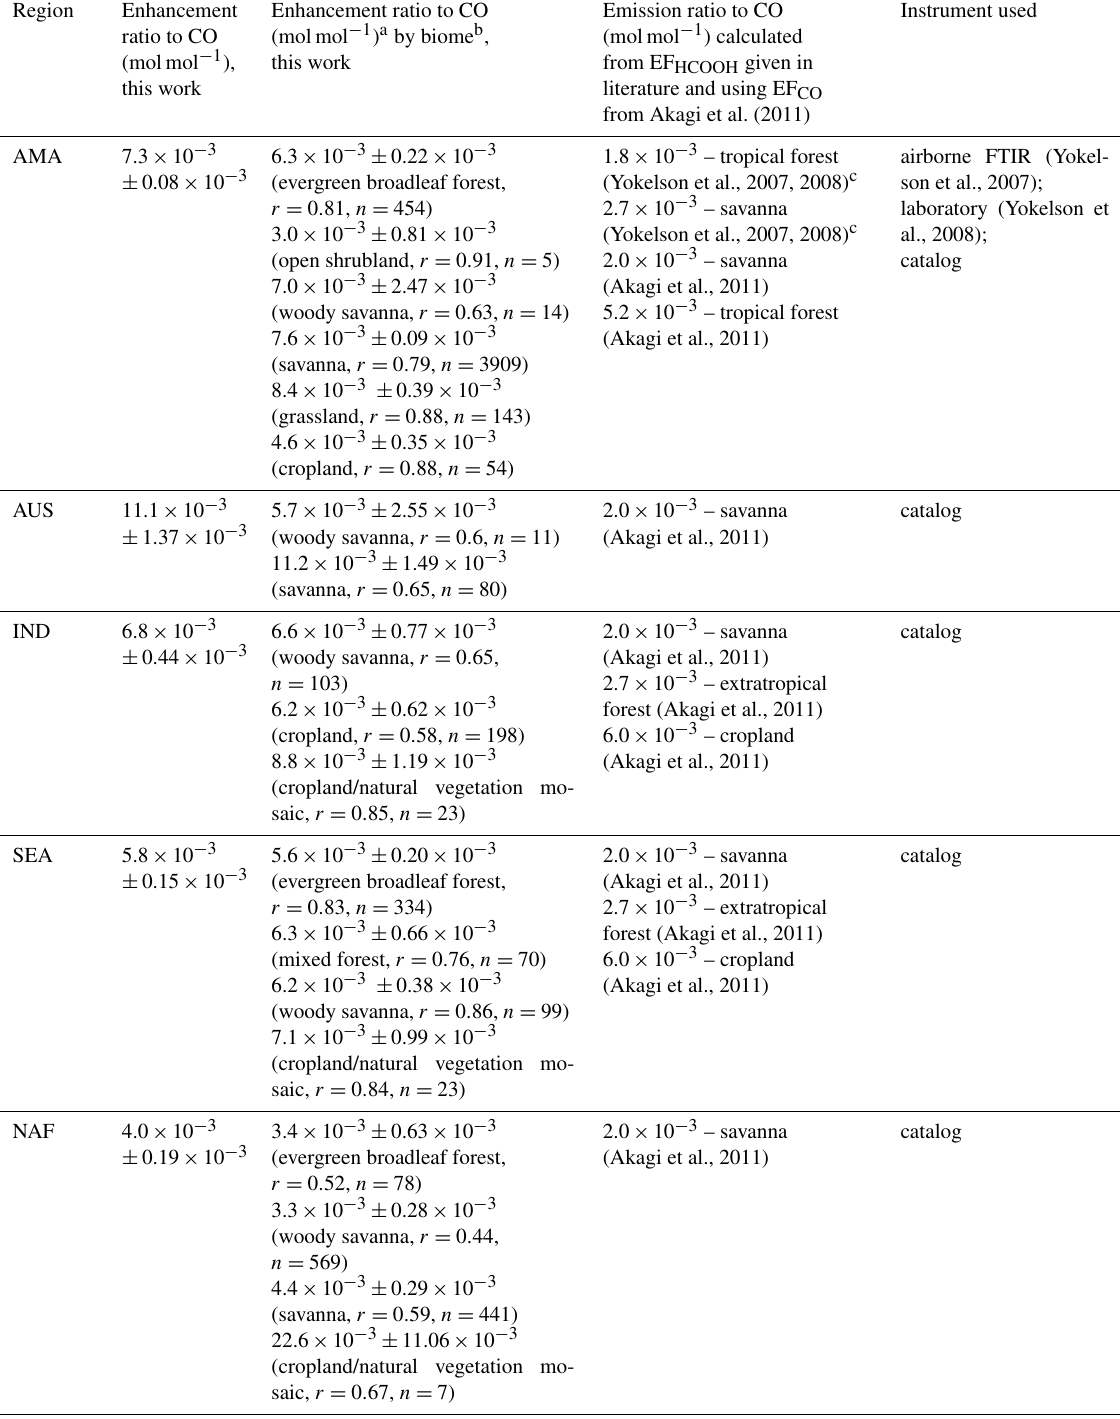
Table 3. Enhancement ratio of HCOOH relative to CO (molmol − 1 ) with its standard deviation and enhancement ratio of HCOOH relative to CO (molmol − 1 ) by biome with its standard deviation calculated in this work. For each enhancement ratio by biome, the correlation coefficient and the number of MODIS hotspots are provided. The enhancement ratios are compared to emission ratios calculated from emission factors given in the literature for the seven studied regions. For the calculation of these emission ratios, the emission factors of CO for the corresponding fuel type given in Akagi et al. (2011) are used. Emission ratios of HCOOH relative to CO (molmol − 1 ) calculated from the emission factors of HCOOH given in Akagi et al. (2011) for the corresponding fuel type are also provided.